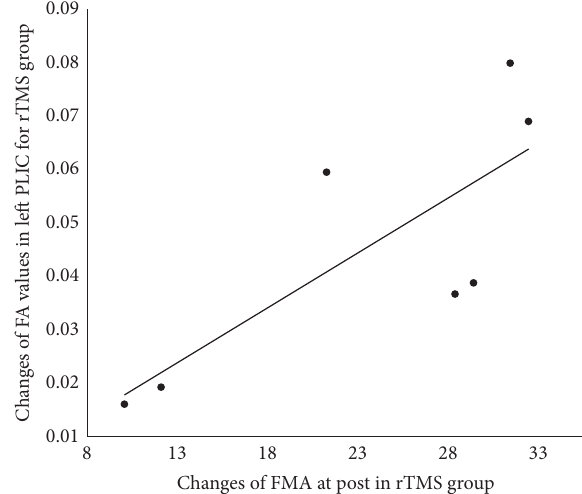
Figure 4: Relationship between changes of FA value in the ipsile- sional posterior limb of internal capsule and changes of FMA score after rTMS treatment in the RT group (correlation coefficient 𝑟 = 0.78 , 𝑝 = 0.039